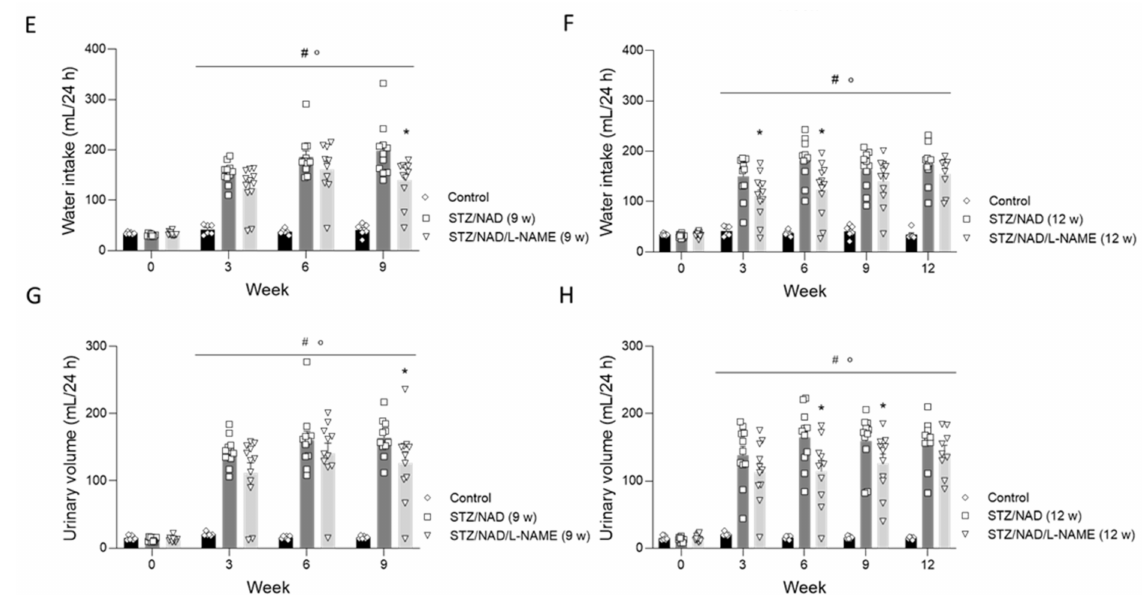
Figure 1. Changes in body weight ( A , B ), food consumption ( C , D ), water intake ( E , F ), and urinary volume ( G , H ) in STZ/NAD and STZ/NAD/L-NAME rats for a period of 9 or 12 weeks. Data are presented as mean ± SEM. * p < 0.05 vs. STZ/NAD, # p < 0.05 vs. non-diabetic control animals, and ◦ p < 0.05 vs. baseline values.